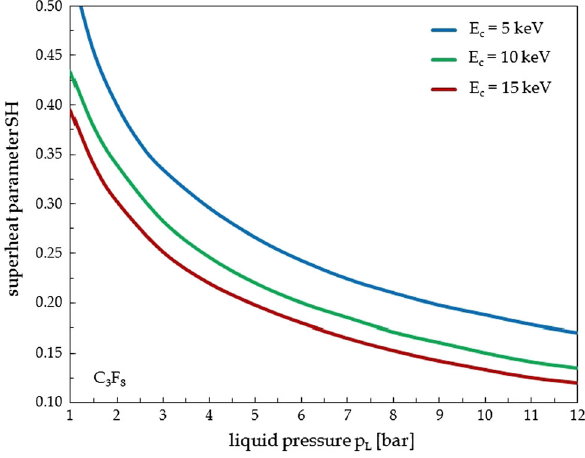
Fig. 2 Distributions of SH vs. p L using E c as a